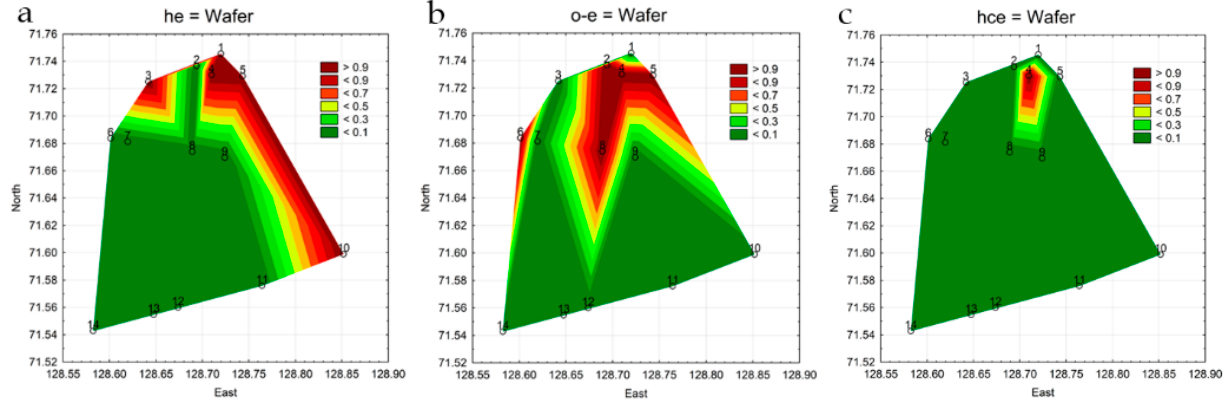
Figure 10. Statistical maps of bioindicator distributions in the 14 studied water bodies: ( a ) hypertrophic (he); ( b ) from oligo-to-eutrophic (o–e); ( c ) obligate nitrogen heterotrophic taxa needing continuously elevated concentrations of organically bound nitrogen (hce).